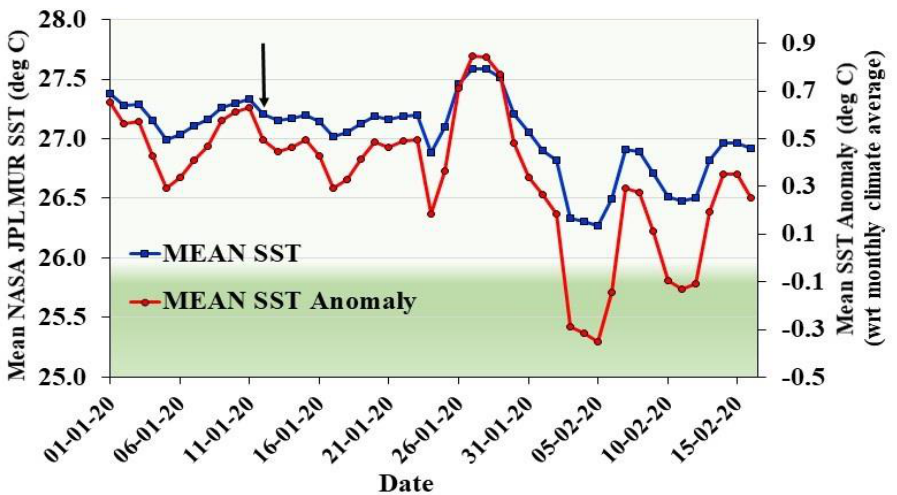
Figure 15. Time series of sea surface temperature (SST) and SST anomaly over the Taal volcano and surroundings (Latitude: 13 °N - 15 °N; Longitude: 120°E - 122 °E). The downward black arrow shows the day of the volcanic eruption.